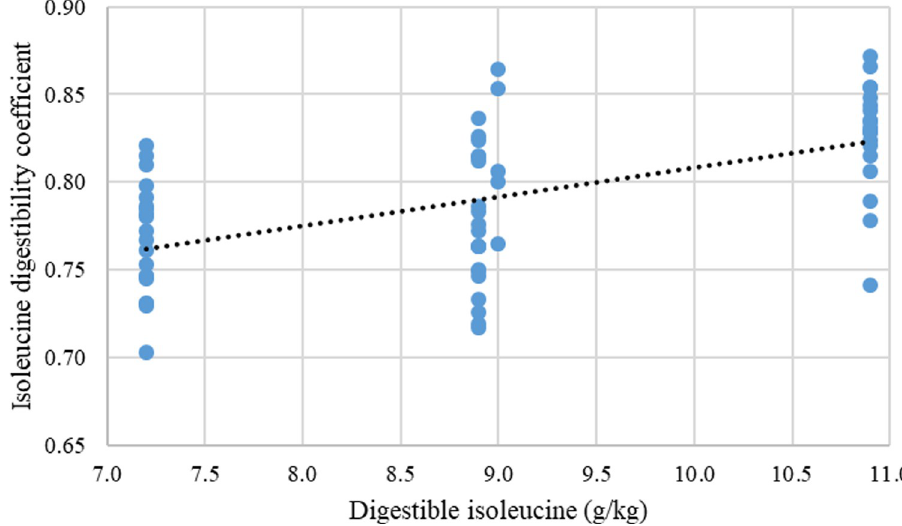
Fig 10. Linear relationship (P < 0.001; r = 0.560) of dietary digestible isoleucine on isoleucine digestible coefficient where: Digestible isoleucine (coefficient) = 0.6443 + 0.0164 × digestible isoleucine (g/kg) . https://doi.org/10.1371/journal.pone.0266080.g010 (P = 0.953; r = 0.007). Similarly, with the exception of the influence of AME on relative fat pad weights (P = 0.027; r = 0.275) feed intake, resultant FCR and fat pad weights were not corre- lated with any other parameters of nutrient utilisation (P range from 0.155 to 0.953 and r from